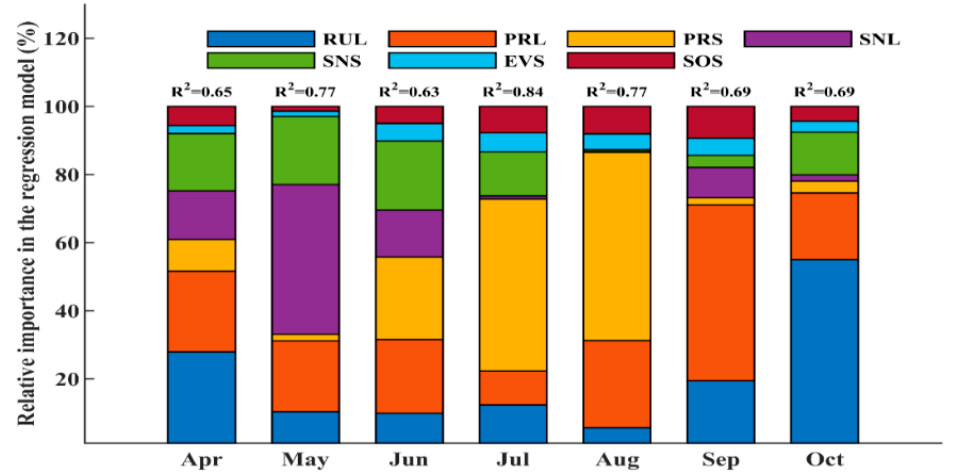
Figure 9. Relative importance analysis of the influence factors in the key area of runoff at Shigu station.